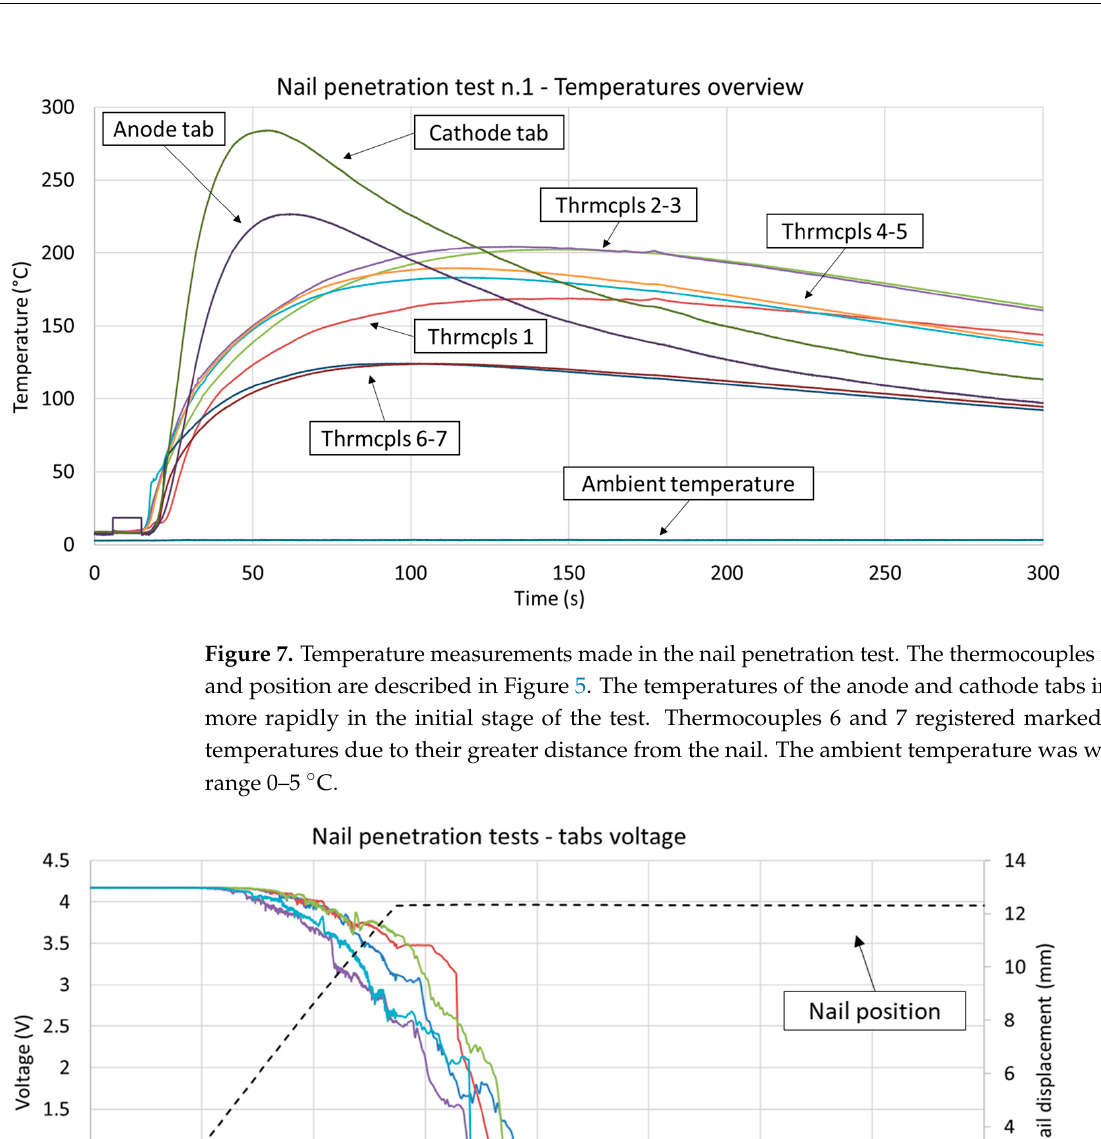
Figure 8. Overview of the Li-ion cells voltage and nail displacement observed during the nail penetration tests. All curves showed similar behavior and reach 0 V approximately 25 s after varying the initial voltage. As the nail penetrates further in to the cell volume, the slope (i.e., its absolute value) increases, suggesting a reduction in the electrical short circuit resistance.